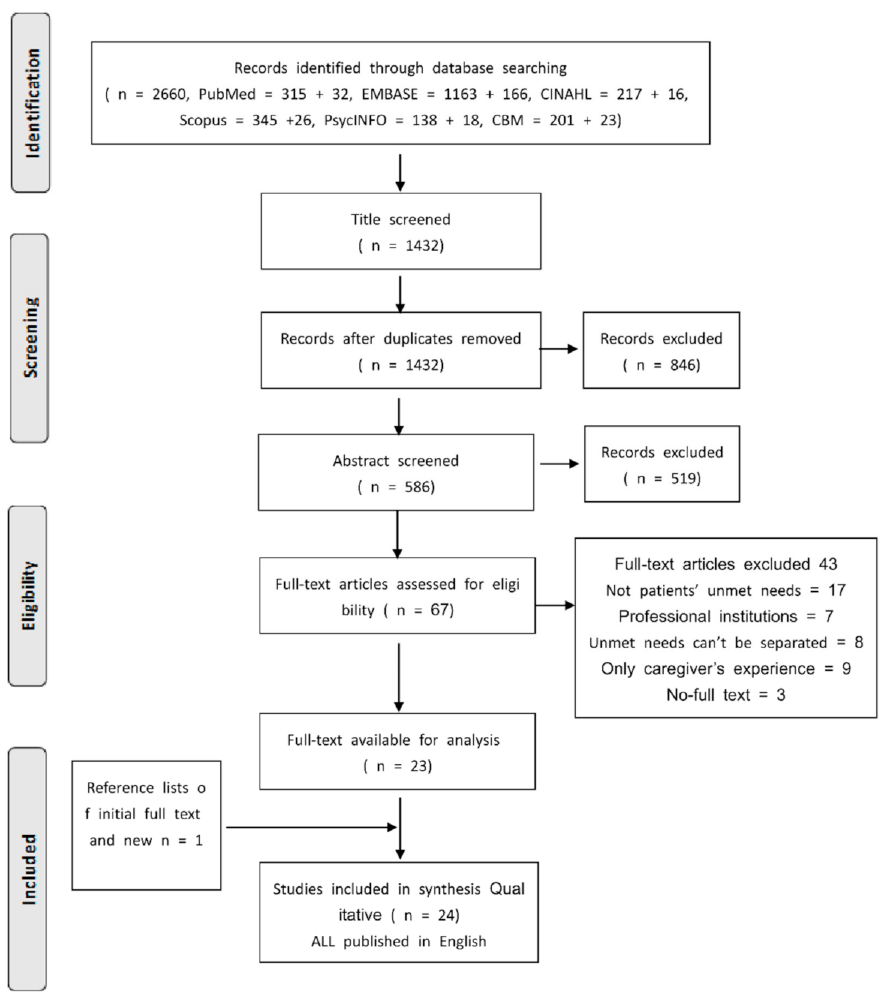
Figure 1. Literature identification